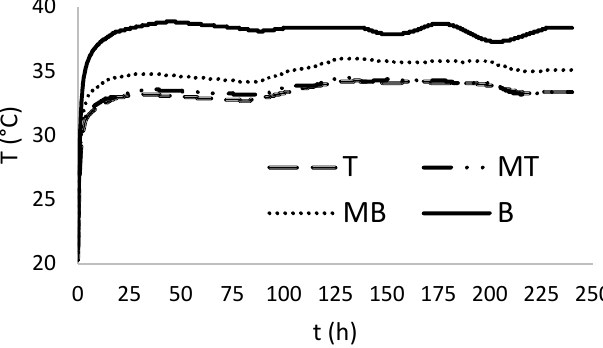
Figure 7. Temperature profiles of the measurement lines T (Top), MT (Medium Top), MB (Medium Bottom), and B (Bottom) for the whole experiment of a 30% ( v / v ) of HFO4E and N 2 gas mixture.